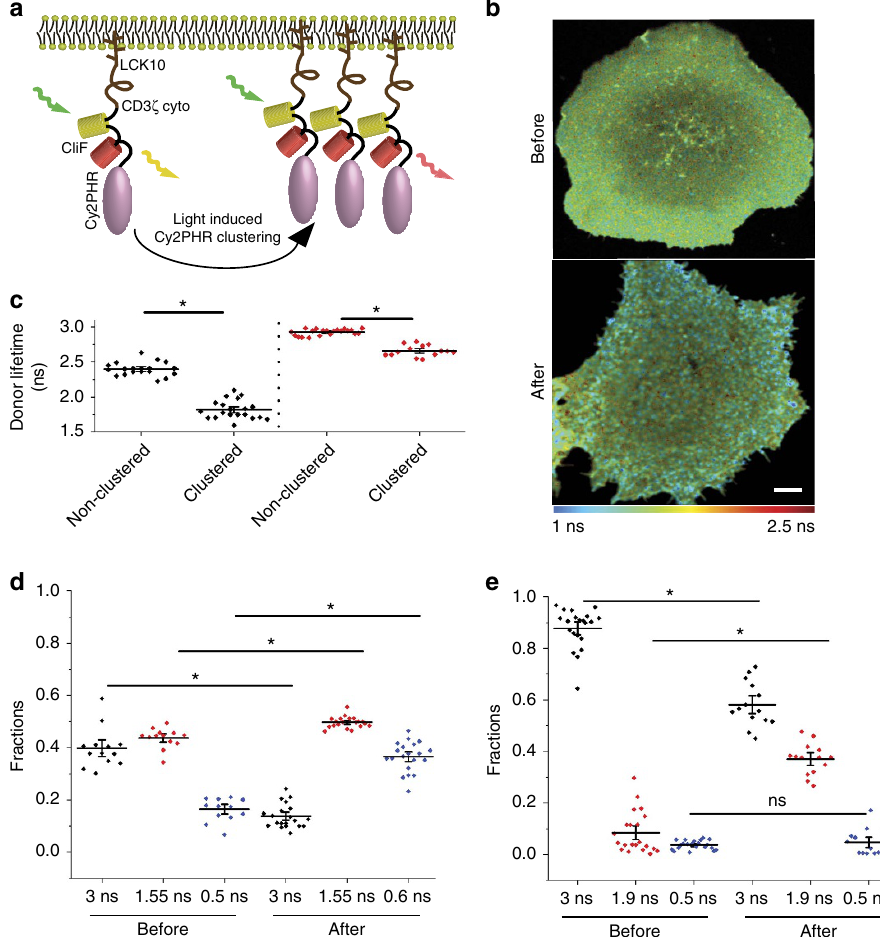
Before After Figure 2 | FLIM analysis of the donor fluorescence in CY2PHR-CliF. ( a ) Schematic drawing of CY2PHR-CliF consisting of a membrane anchor (Lck10), the cytosolic tail of CD3 z (CD3 z cyto ), CliF and CY2PHR. Upon irradiation with light, CY2PHR-CliF forms clusters, leading to an enhanced intermolecular FRET sensed by CliF. ( b ) Intensity-weighted, pseudocoloured FLIM image of Venus (coloured blue to red for short to long lifetimes, as indicated) in COS-7 cells expressing CY2PHR-CliF before and after 30s irradiation with low intensity 488nm light to induce clustering. Scale bar, 2 m m. ( c ) Average donor lifetime of CY2PHR-CliF (black) and CY2PHR-Venus (red) in transfected cells before and after 488nm light irradiation, that is, under non-clustered and clustered conditions. Horizontal bars indicate means ( n ¼ 20 cells), error bars are s.e.m.; * P o 0.01 (unpaired t -test). ( d , e ) Venus lifetime fractions in CY2PHR-CliF ( d ) and CY2PHR-Venus ( e ) before and after light-induced clustering. The fractions were obtained by fitting Venus lifetime intensity decays to a triple exponential decay function with the indicated lifetime values. Horizontal bars indicate means and error bars are s.e.m. Data shown in d , e are from at least 15 cells, * P o 0.01 (unpaired t